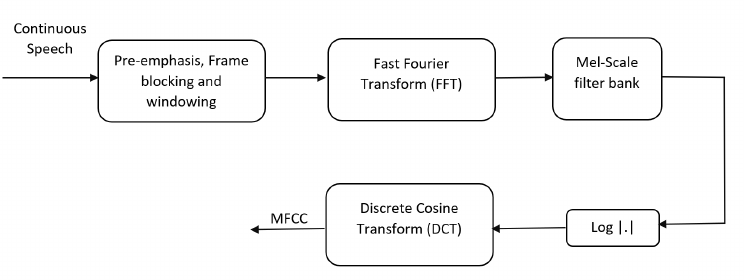
Figure 2. Block diagram for computation of mel frequency cepstral coefficients [35].